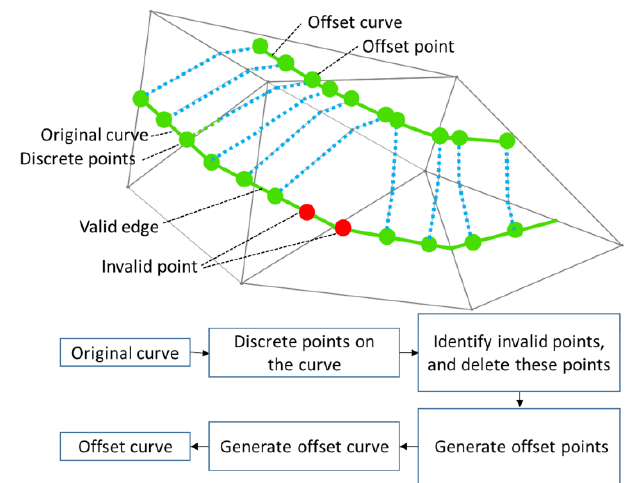
Figure 6. Algorithm flow of the curve offsetting based on a discrete point (CODP).